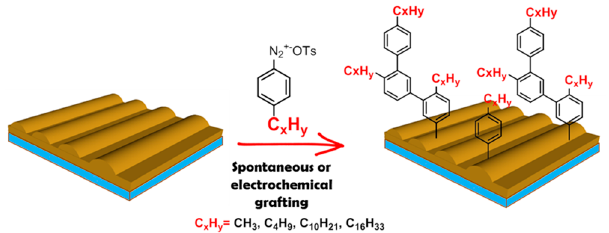
Figure 1. The scheme of the preparation of lipophilic gold